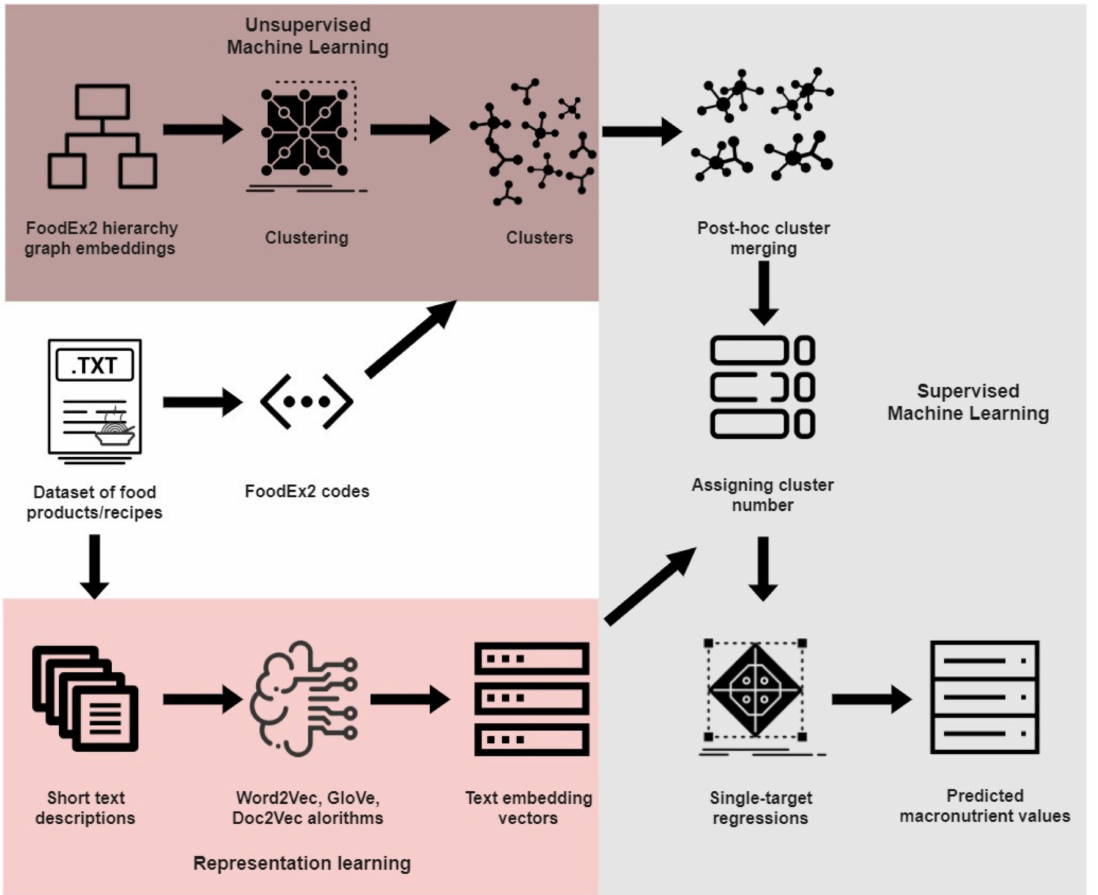
Figure 1. Flowchart of the